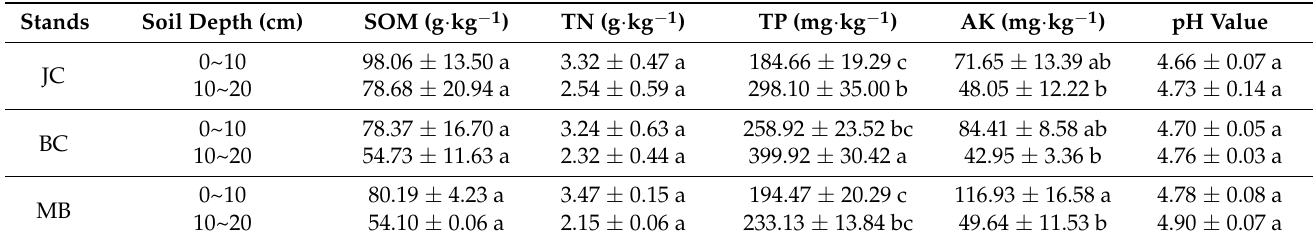
Table 1. The soil chemical characteristics of the three